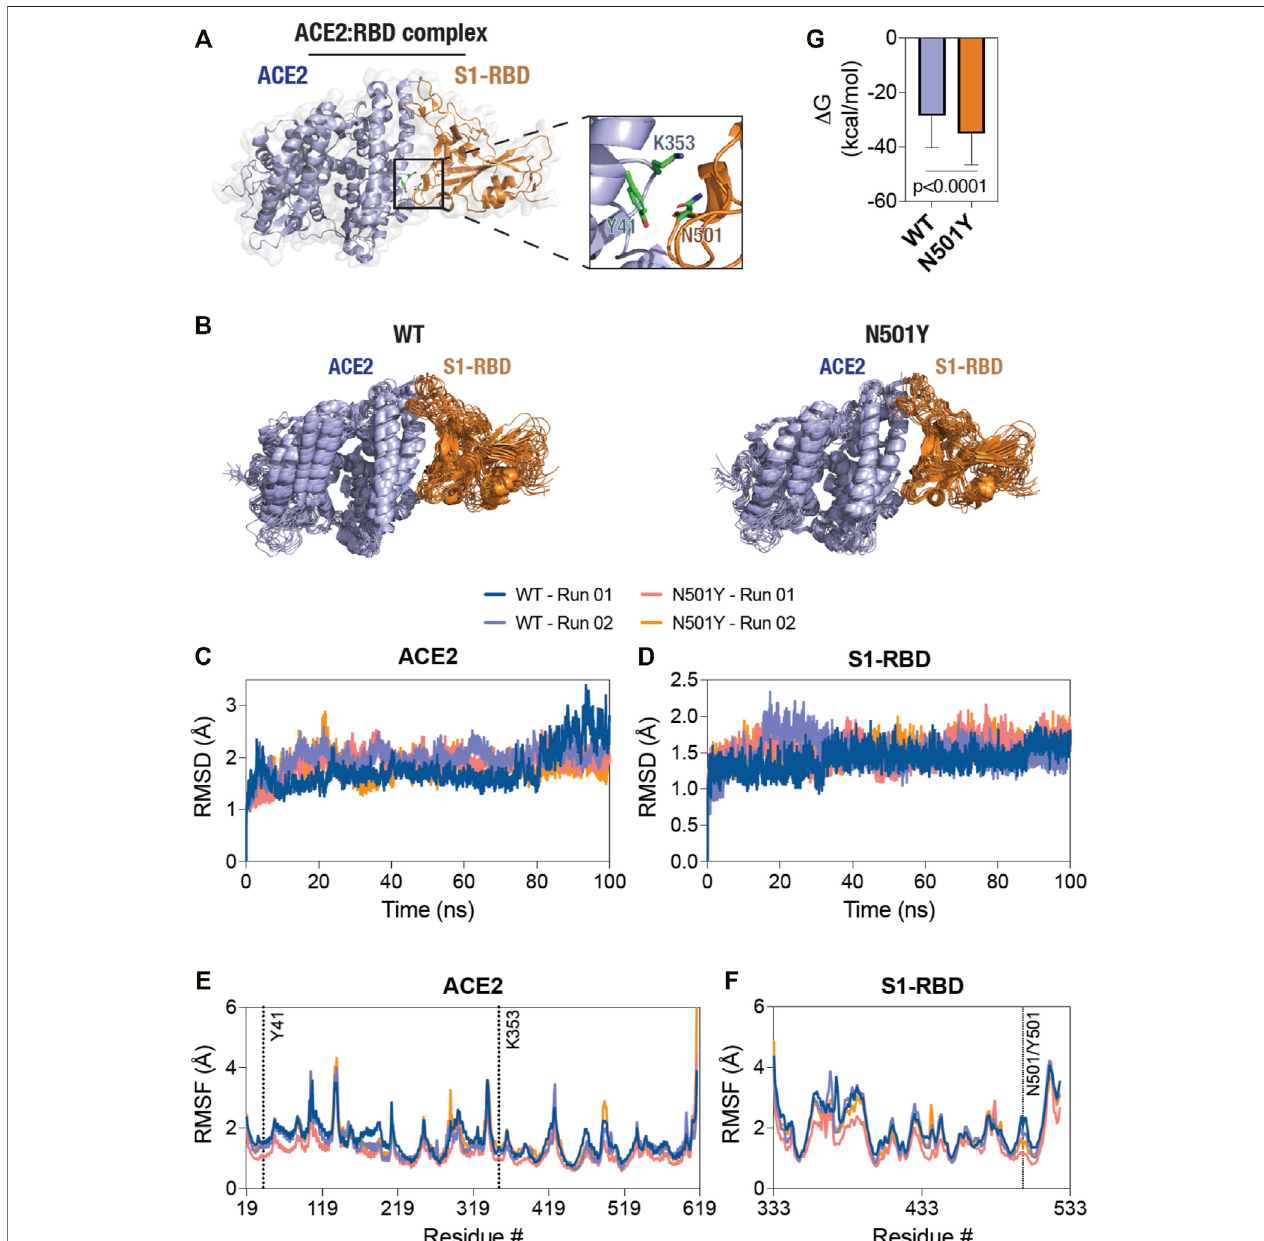
FIGURE1| DecreasedstructuraldynamicsoftheN501YmutantS1-RBDincomplexwithACE2. (A) CartoonrepresentationoftheACE2-S1-RBDstructure(PDB: 6M0J (Lan et al.,2020) showingthe relative positioning ofresidues Y41and K353 inACE2 (lightblue) and residue N501 inS1-RBD (orange). (B) Cartoonrepresentation of the WT (left panel) and the N501Y mutant (right panel) ACE2-S1-RBD complex showing structural evolution of the complex over time in a 100 ns all-atom, explicit solvent MD simulation. Composite images were prepared using 11 consecutive frames from up to 100 ns simulations with each frame being 10 ns apart. (C, D) Graph showing backbone (C α ) root-mean-square deviation (RMSD) values of ACE2 (C) and S1-RBD (D) obtained from the simulation of the WT and N501Y mutant ACE2-S1-RBD complexes. (E,F) Graph showing backbone (C α ) root-mean-square fl uctuation (RMSF) values of ACE2 (E) and S1-RBD (F) obtained from up to 100 ns simulationsoftheWT andN501YmutantACE2-S1-RBDcomplexes. (G) Graphshowing bindingfreeenergy changes( Δ G,kcal/mol)obtainedfrom thelast50nsofMD simulation using the MM-PBSA method (mean ± S.D.).